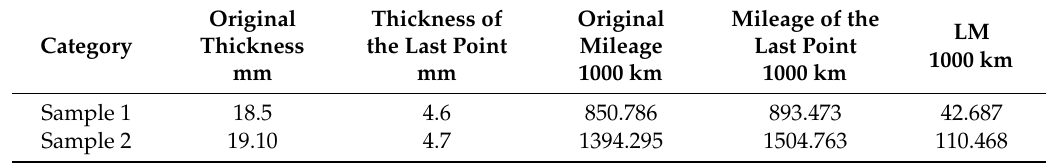
Table 4. The selected wear data for PCCS.